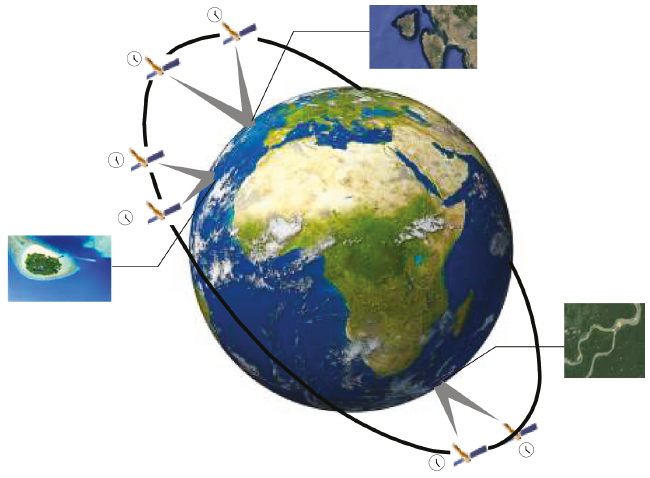
Figure 1: Sketch of landmark-based automatic